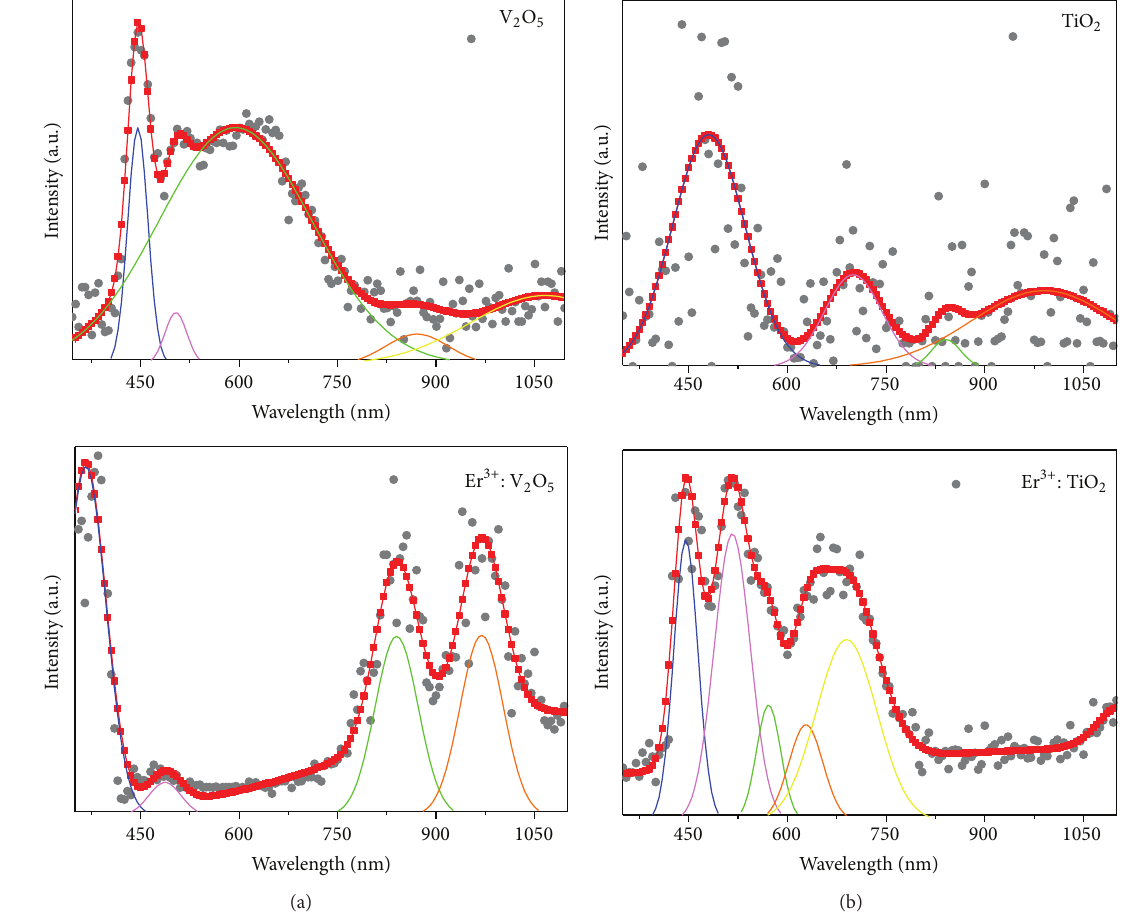
Figure 4: Room temperature PL spectra of erbium-undoped/erbium-doped (a) V 2 O 5 and (b) TiO 2 thin